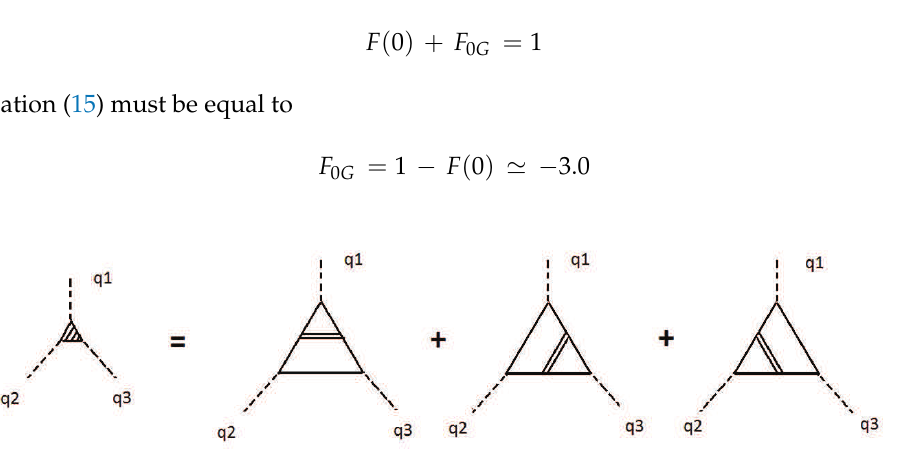
Figure 2. Diagrams describing the first approximation for the Standard Model contribution to three-graviton vertex (Equation (2)). Simple lines correspond to matter fermions (quarks, etc.) and double lines correspond to weak bosons W